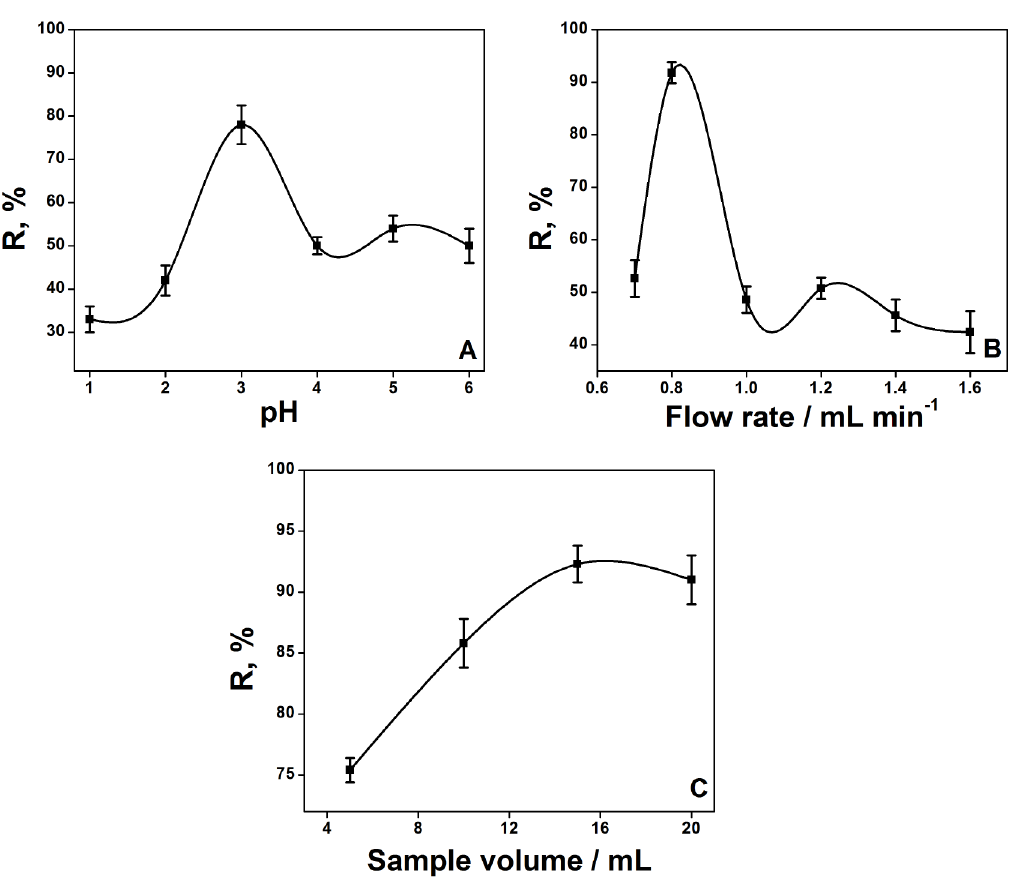
Figure 2: Optimization and effect of different parameters on biosorption, preconcentration of Cr(VI) (A) Effect of pH, (B) Effect of flow rate and (C) Effect of sample loading. The percentage recovery (R, %) is calculated by concentration after preconcentration/concentration before